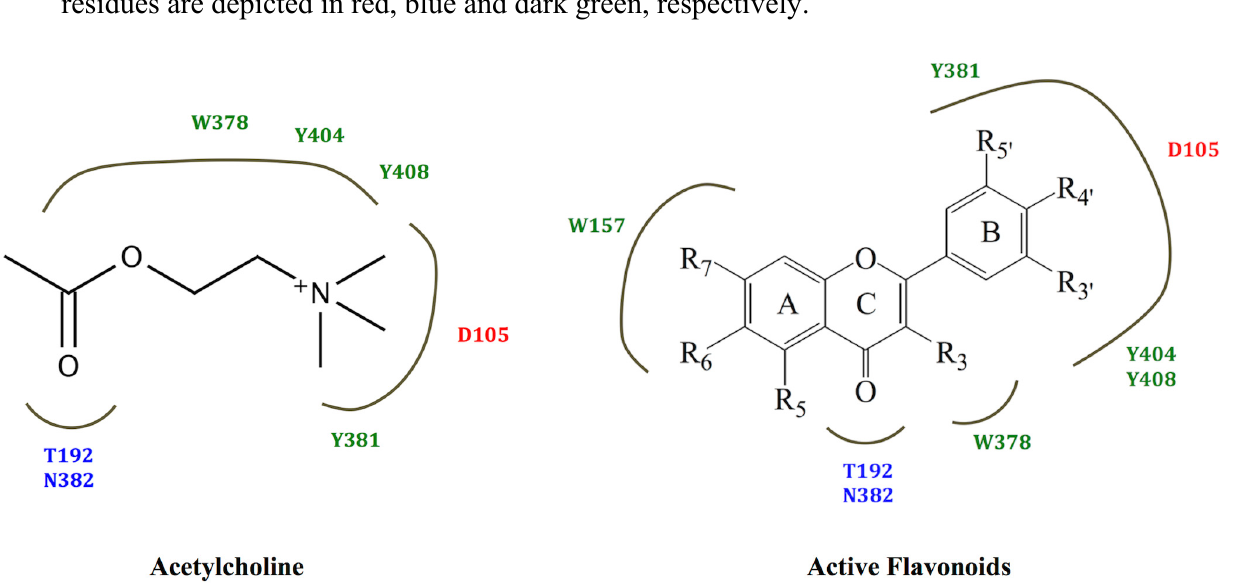
Figure 5. The structural binding analysis map for acetylcholine and a composite map for the active flavonoids, 3',4',5',5,6,7-hexamethoxyflavone ( 4 ), luteolin ( 6 ) and ombuin ( 9) , obtained from molecular modelling studies. Negatively-charged, polar and hydrophobic residues are depicted in red, blue and dark green,